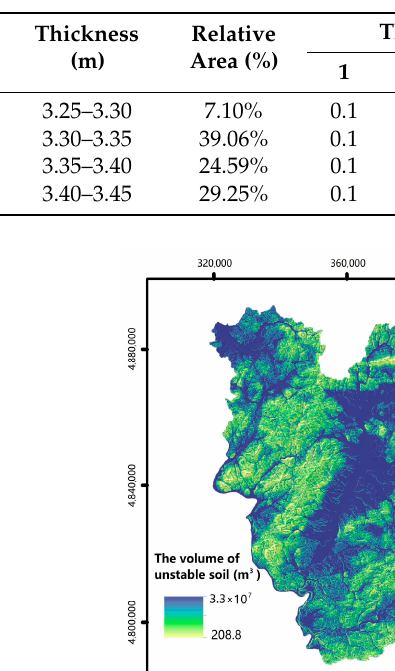
Table 2. Soil thickness in Jiaohe County, Jilin Province.